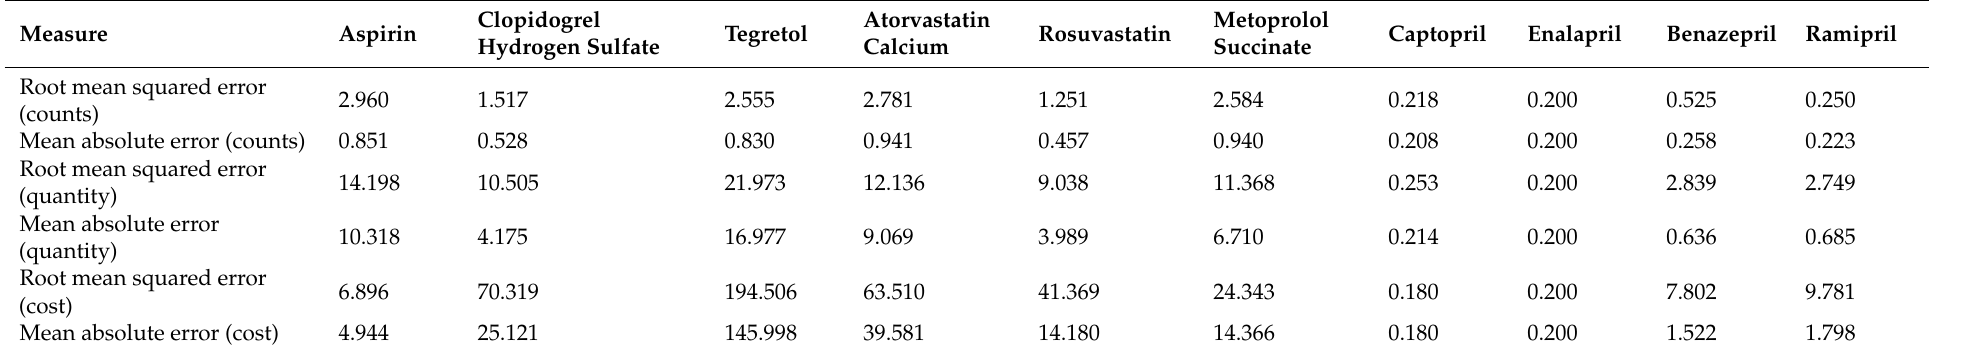
Table 4. Early consumption allocation scenario: multi-output regression forecast results for 10 typical